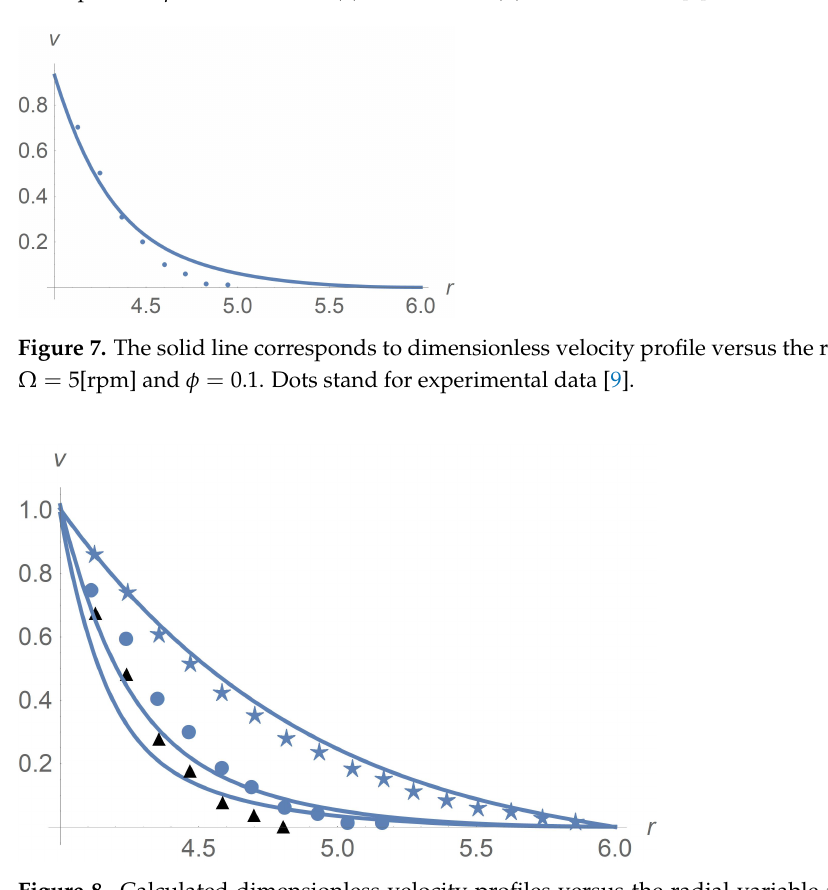
Figure 6. Dimensionless velocity profiles for Ω = 5 [ rpm ] . The curves from the bottom upwards correspond to φ = 0,0.1 and 0.3. ( a ) calculations, ( b ) measured data [9].